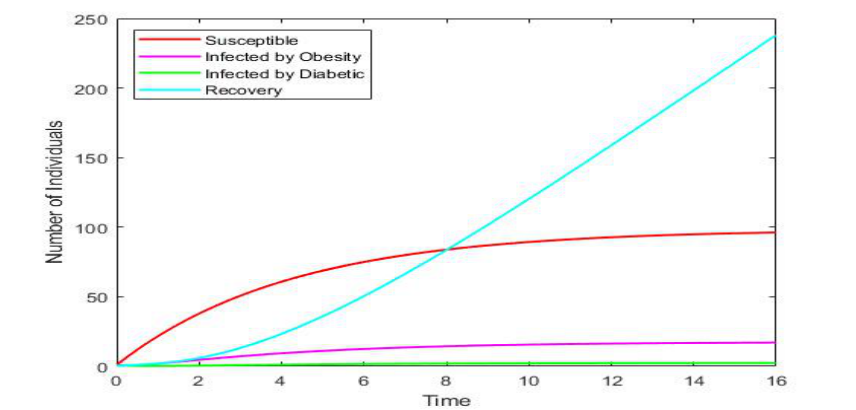
Figure 2: Obesity and Diabetic with control parameters